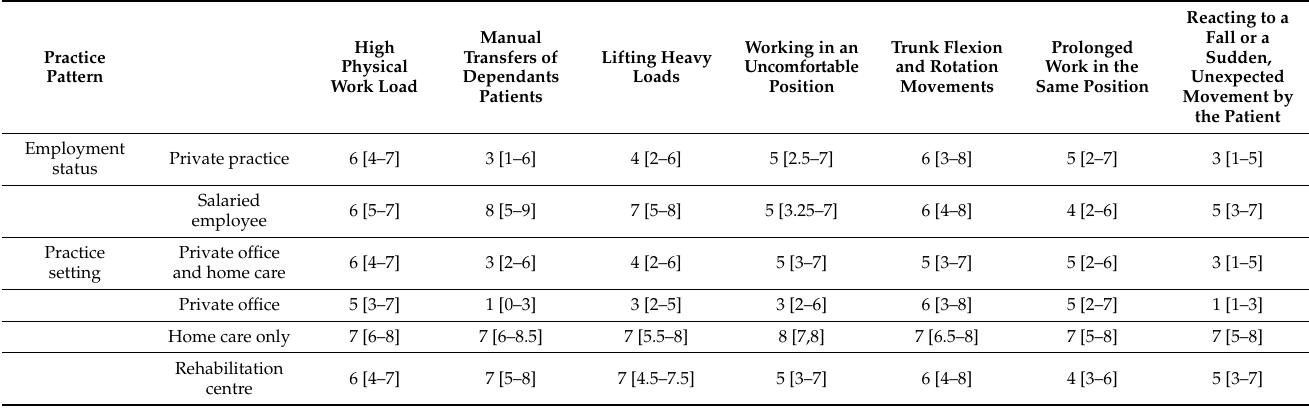
Table A1. Physiotherapists’ Perceived Levels (Median [IQR]) of Exposure to Biomechanical Risk Factors, as a Function of Practice